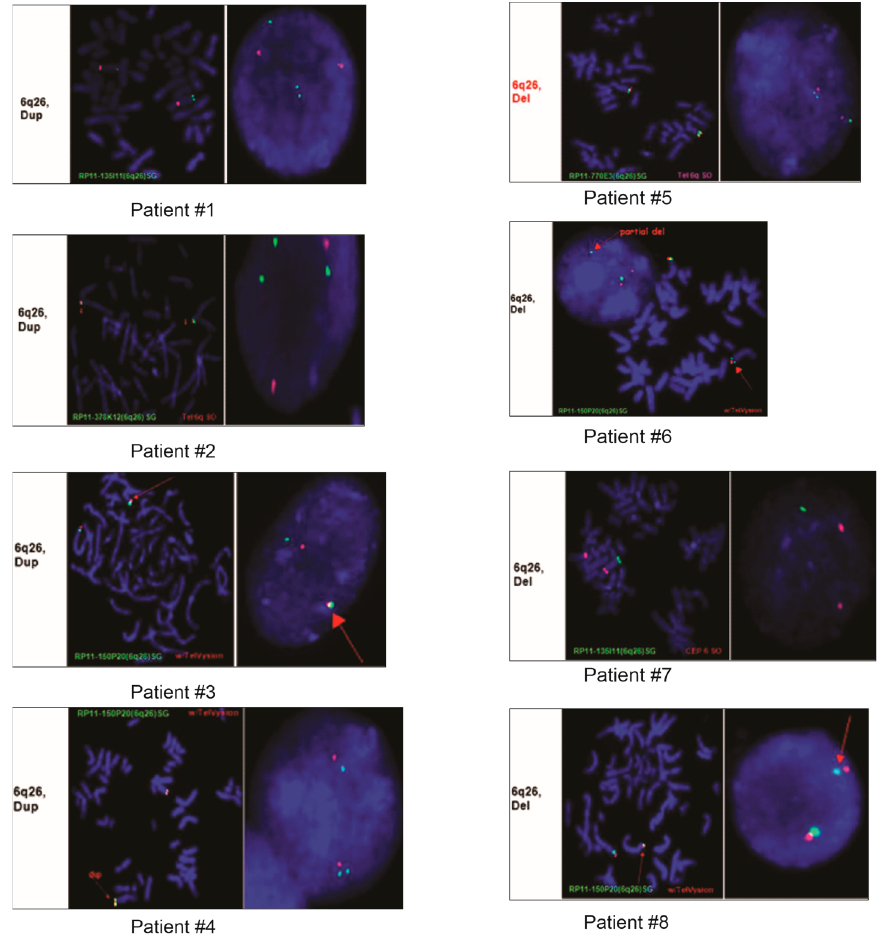
Figure 2. FISH images from eight of the nine patients demonstrating duplication or deletion within the 6q26 region.